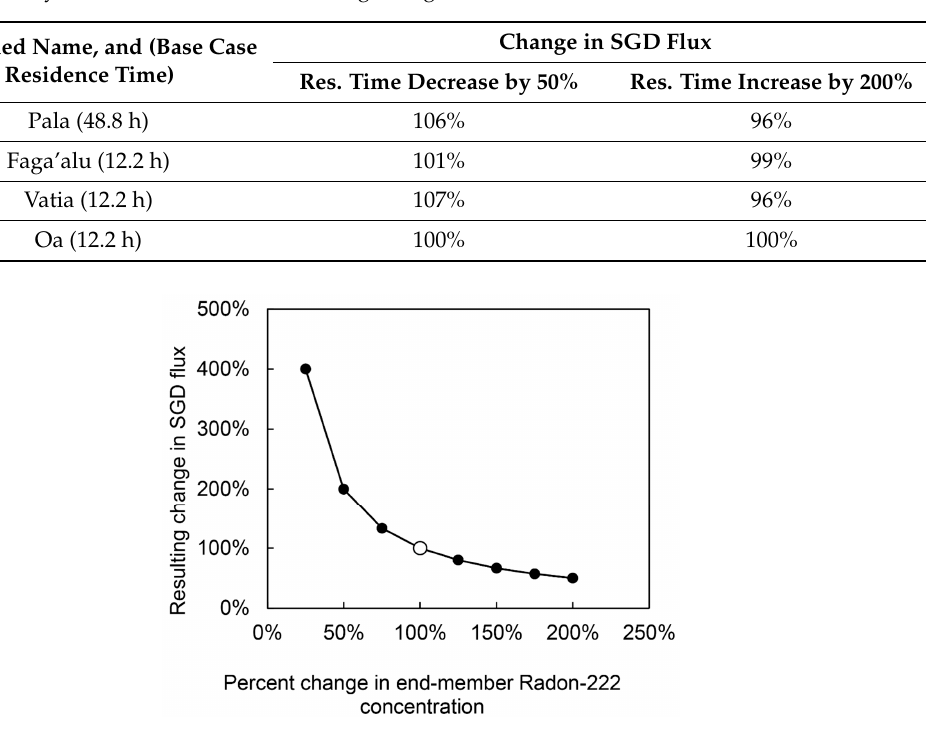
Table A1. Sensitivity testing results for changes in residence times in each bay. Residence times were multiplied by either 0.5 or 2 and the resulting change in calculated total SGD flux was recorded.